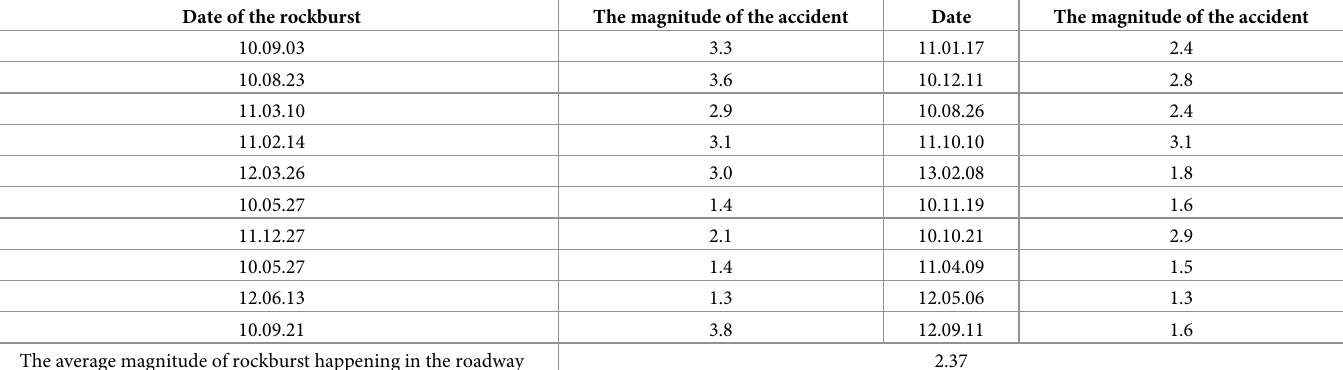
Table 4. Corresponding magnitudes when rockburst happened in the drift.